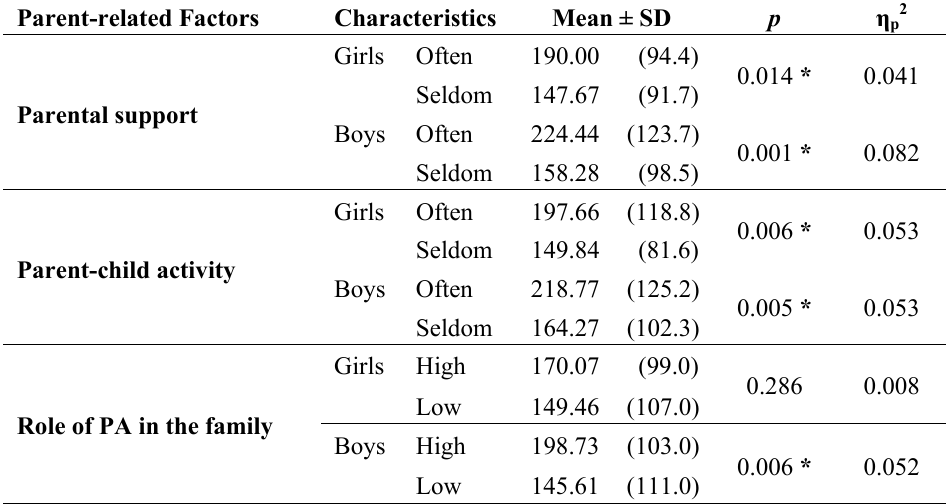
Table 3. Parent-related factors and parentally reported children’s MVPA. Parent-related